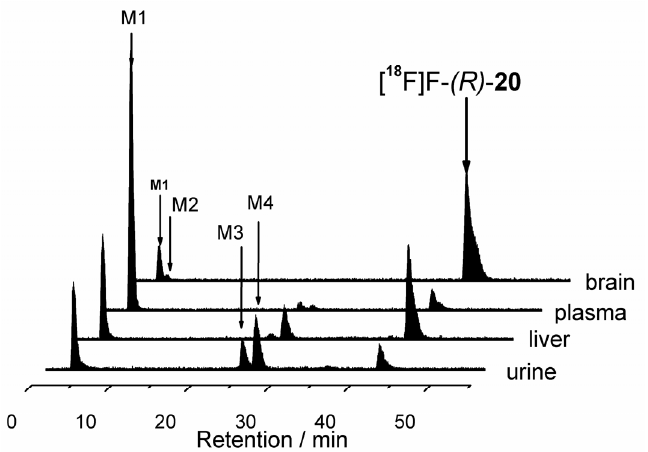
Figure 4. Stacked analytical radio-HPLC profiles of brain, plasma, liver and urine samples; samples were collected 30 min after injection of the radiotracer [ 18 F]- ( R )-20 ; t the parent compound ca. 42